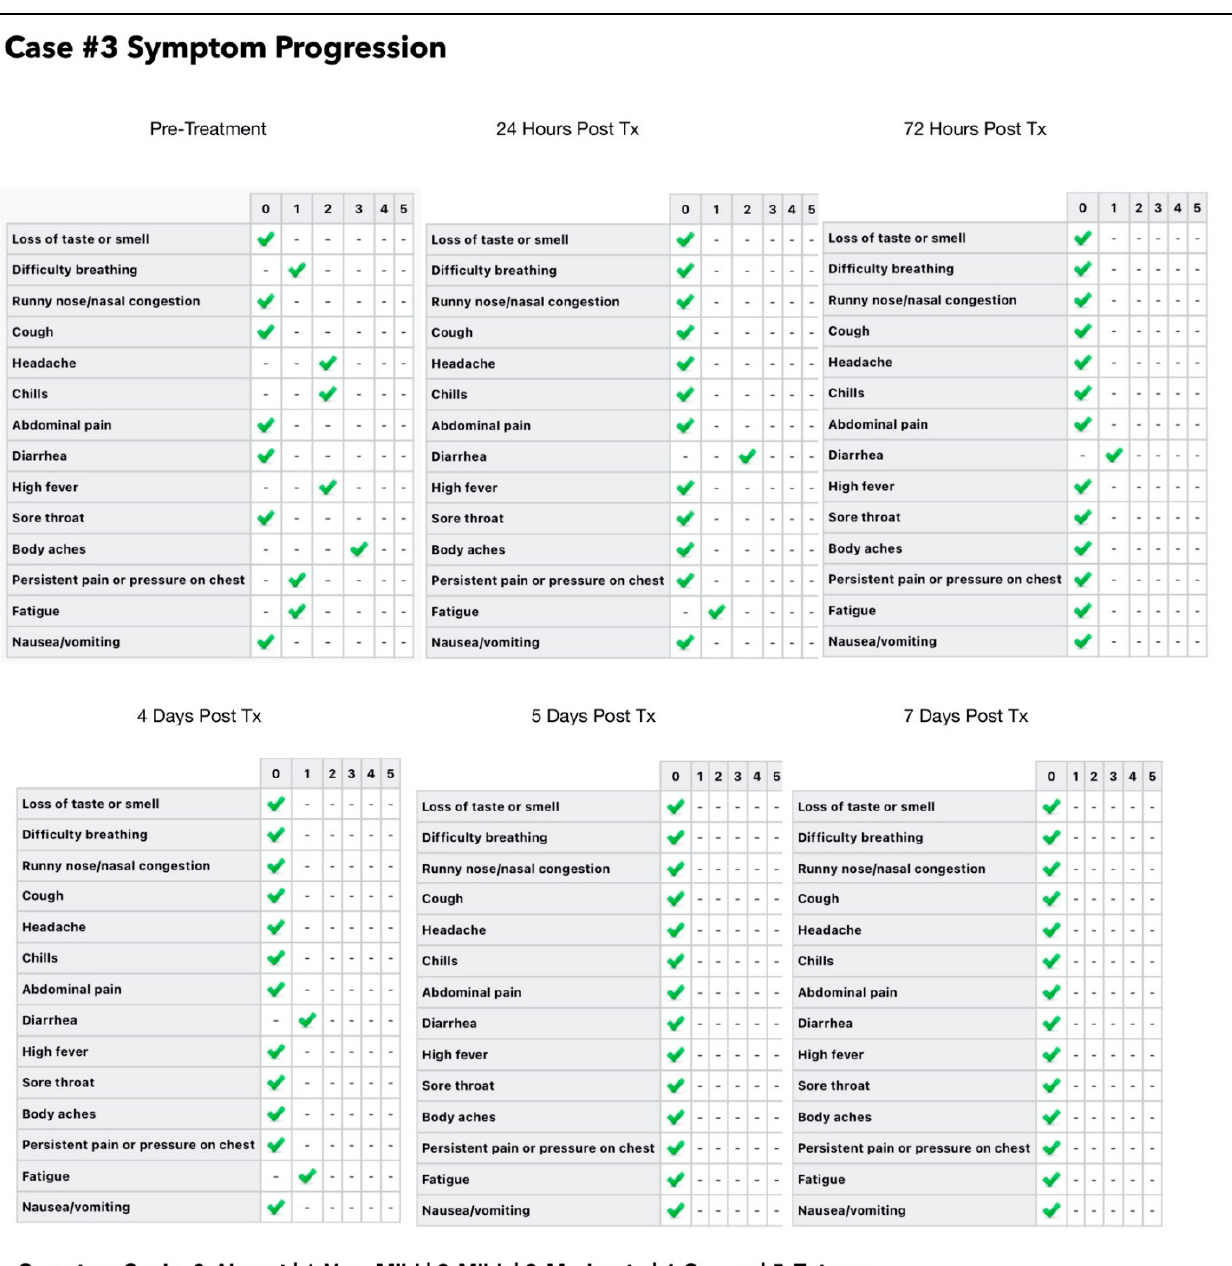
Figure 8. Shows the symptoms progression of subject three